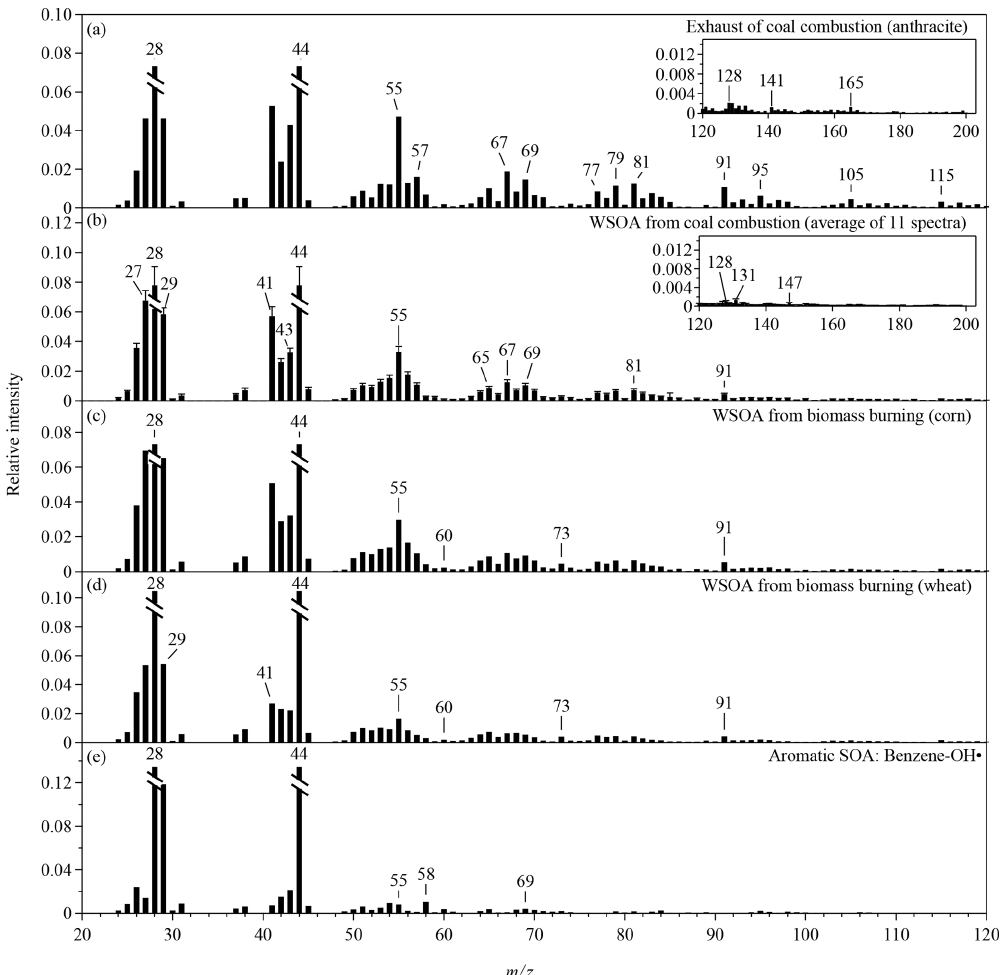
Figure 2. The CV mass spectra of anthropogenic OA that are not included in Fig. 1. The intensities of m/z 28 and 18 are calculated as 100% and 22.5% of the intensity of m/z 44 for all the spectra (Aiken et al., 2008). The relative intensities of m/z 28 and 44 in all panels are truncated to half of the original intensities. Mass spectra are shown for the m/z range of 20 to 120. The inserts in panels (a) – (b) show extended m/z ranges for the corresponding